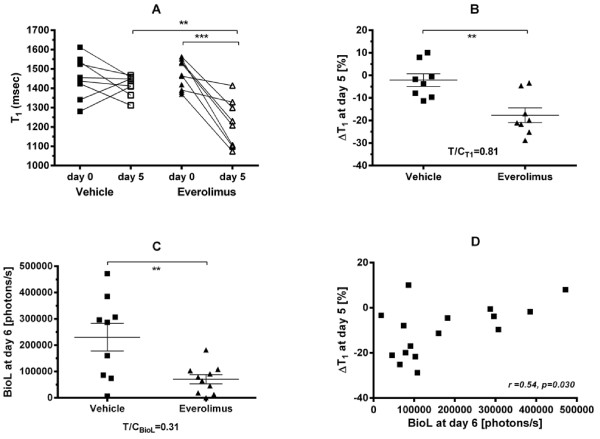
Everolimus decreases the T1 and bioluminescence of cervical B16/BL6 melanoma metastases. C57/BL6 mice bearing B16/BL6 melanomas were treated with everolimus (10 mg/kg/day) or vehicle for 6 days and the spin–lattice relaxation of protons (T1) in tumours was measured on day 0 and at the endpoint day 6. Lymph-nodes were removed and extracted for measurement of bioluminescence (BioL) as described in Methods. Results show the mean ± SEM, and the individual T1 values (A) and bioluminescence (C), the fractional change in T1 (ΔT1) for the treatments (B), and the Pearson correlations (with the associated r and p values) between BioL and ΔT1(D), where **p < 0.01, ***p < 0.001 as shown.